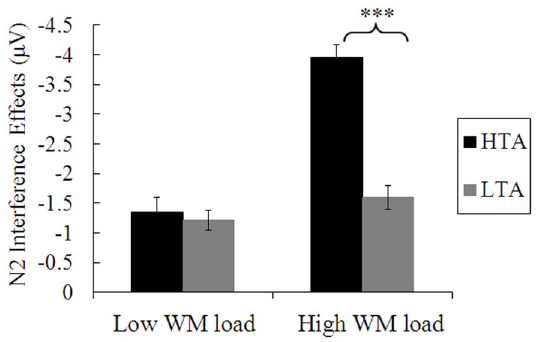
Figure 4. Interference effects (i.e., incongruent-congruent) on N2 amplitudes under low and high working memory (WM) loads, for the high-trait-anxious (HTA) and low-trait-anxious (LTA) groups. Error bars represent standard errors of the means. *** p , .001.